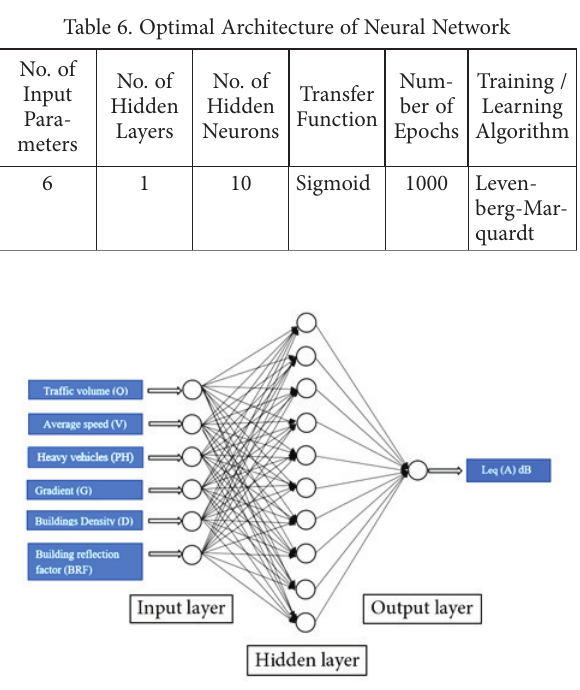
Figure 12. Proposed ANN architecture for traffic